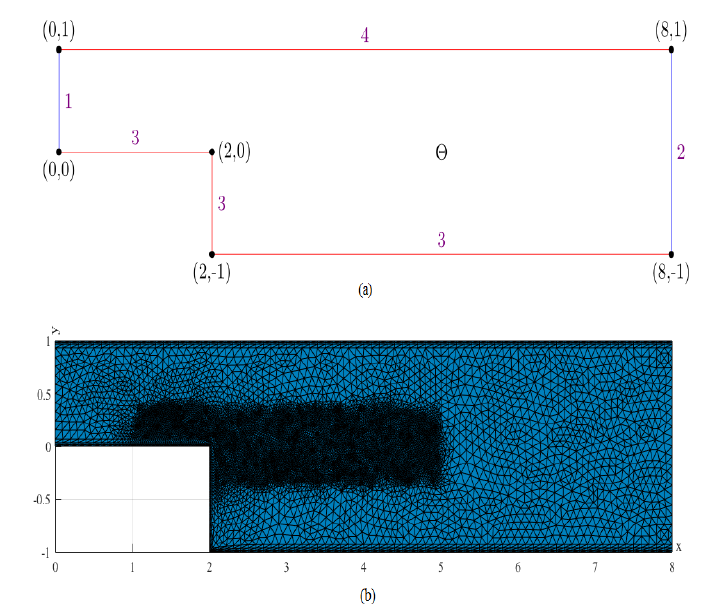
Figure 1. ( a ) The calculation region and the boundary values. ( b ) Spatial mesh on the calculation region. We first obtain the initial 20 CNMFE vorticity coefficient vectors (cid:118) i ( i = 1, 2, · · · , 20) by solving the CNMFE method at the initial 20 time steps and make up the snapshot matrix A = ( (cid:118) 1 , (cid:118) 2 , · · · , (cid:118) 20 ) . Then, according to the way in Section 3.1, we calculate out the eigenvectors φ j ( j = 1, 2, · · · , 20 ) corresponding to the eigenvalues λ j (arranged √ λ 7 (cid:54) 10 − 4 . Thereupon, we merely need degressively) in the matrix A T A that satisfy to take the first six eigenvectors to generate a set of POD bases Φ = ( ϕ 1 , ϕ 2 , · · · , ϕ 6 ) (cid:113) λ j ( j = 1, 2, · · · , 6 ) . Finally, we seek the RDRCNMFE solutions of the with ϕ j = A φ j / (cid:113) + v 2 u 2 components of velocity, the velocity magnitude ( ), and the pressure at t = 4, 6, 8, d d and 10 by using Problem 6 and the formula (37), pictured in photo (b) of Figures 2–17.